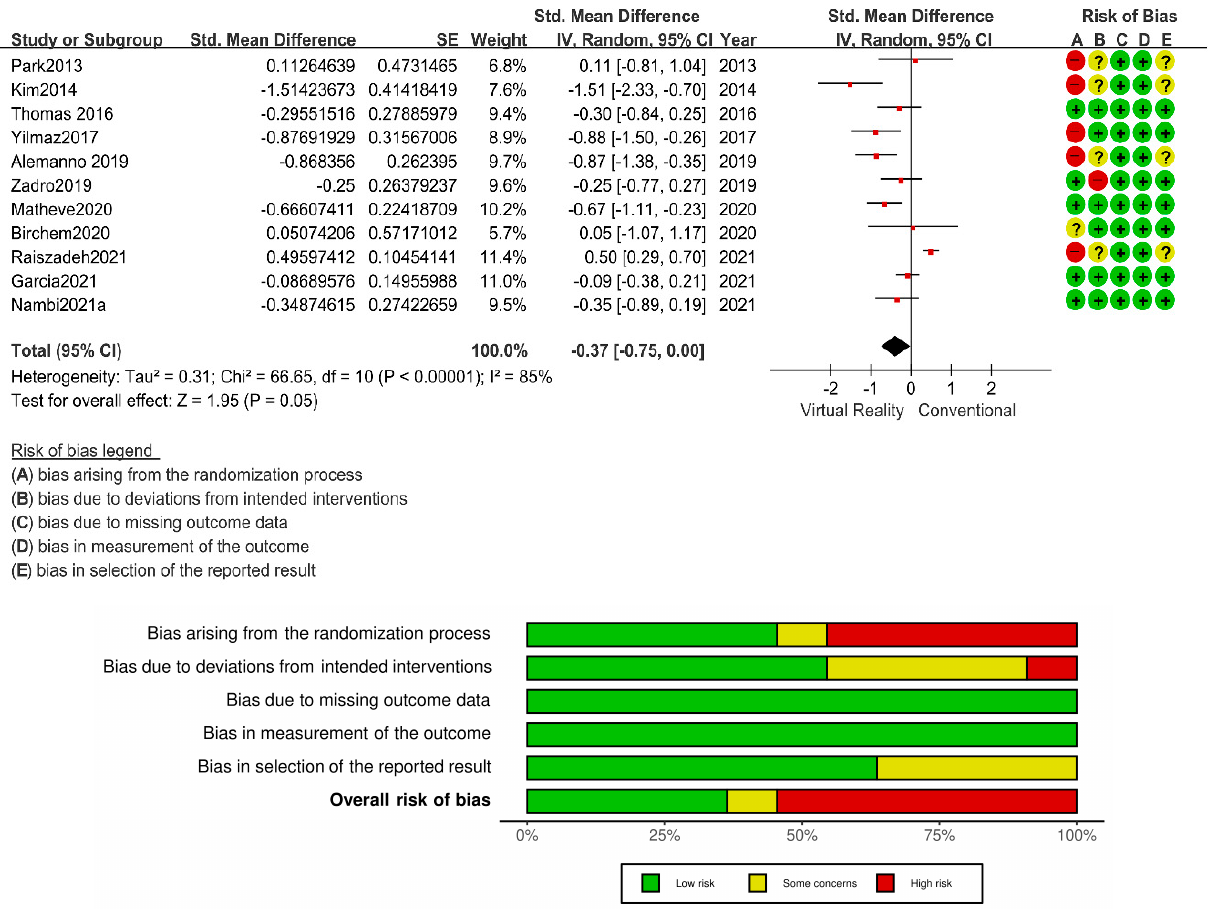
Figure 2. Forest Plot demonstration and Risk of Bias. CI: confidence interval; IV: inverse variance; SE: standard error; Std: standardized [10–20].